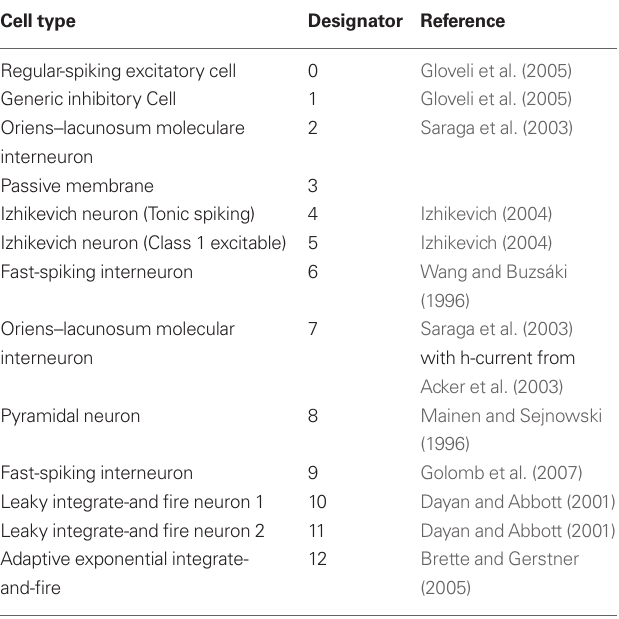
Table A | Model neurons currently available in